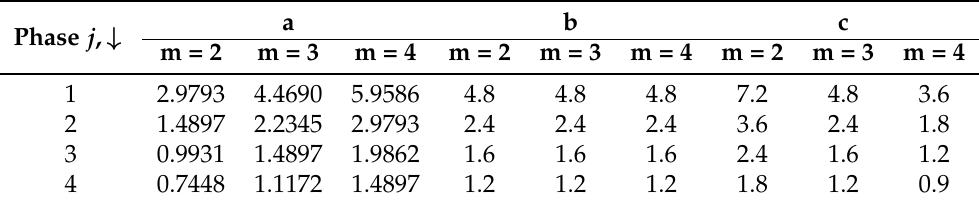
Table 10. Service Rates, µ m for various batch size, m and phase, j in Scenario III. j